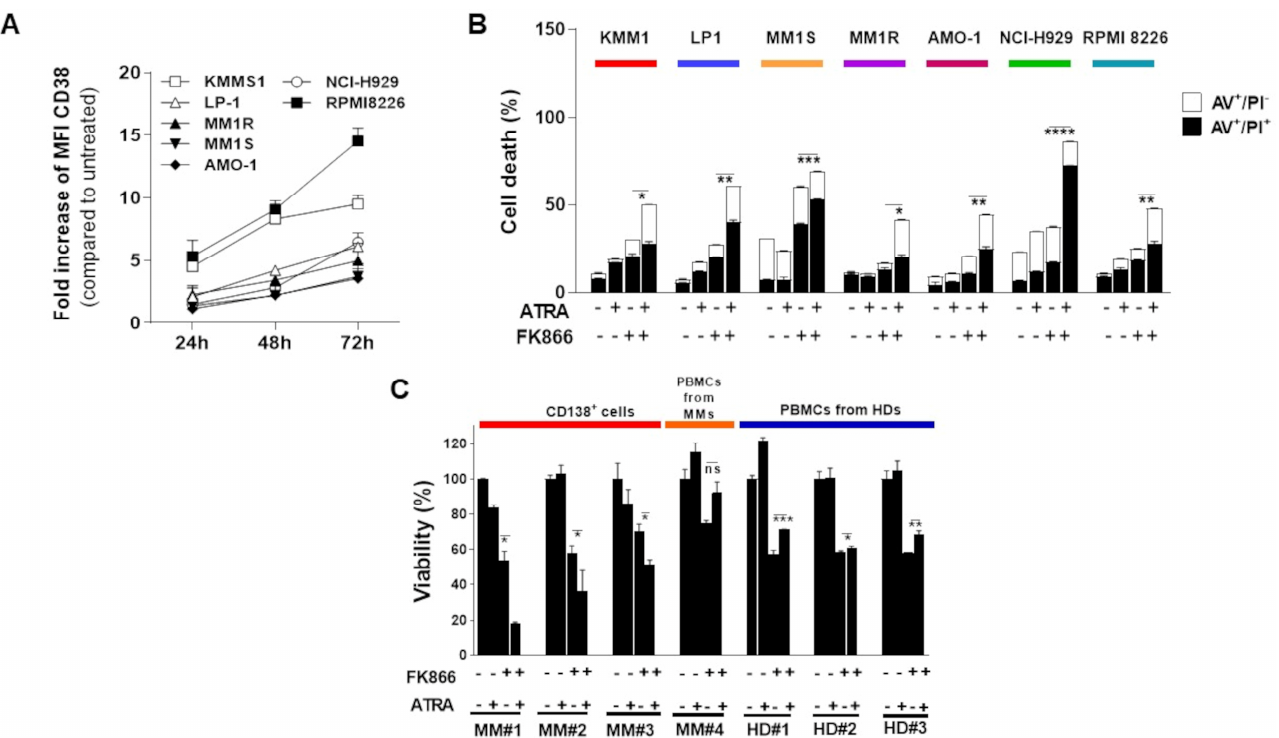
Figure 2. Anti-MM synergistic effects of the NAMPT inhibitor FK866 combined with CD38 inducers. ( A ) Indicated HMCLs were incubated with 10 nM ATRA for 24, 48, or 72 h and then analyzed by flow cytometry. The panel shows the fold increase in CD38 median fluorescence intensity (MFI) compared with control. ( B ) Apoptotic cell death assessed with flow cytometry analysis after Annexin V/PI staining in a panel of HMCLs treated with FK866 (3 nM), ATRA (3 nM) or their combination for 96 h. ( C ) CD138 + cells collected from three MM patients or PBMCs derived from one MM patient and three healthy donors (HDs) were treated with indicated doses of FK866 (3 nM), ATRA (1 nM) and their combination for 72 h. Cell viability was measured by MTS assay. Data in B and C are presented as mean ± S.D ( n = 3). (ns p > 0.05, * p ≤ 0.05, ** p ≤ 0.01, *** p ≤ 0.001, **** p ≤ 0.0001; unpaired t test) .